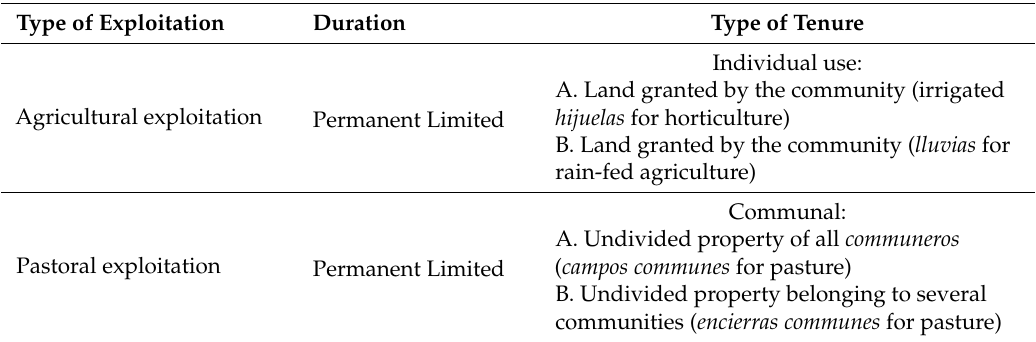
Table 1. Land ownership in an agricultural community of IV Region of Coquimbo Source: